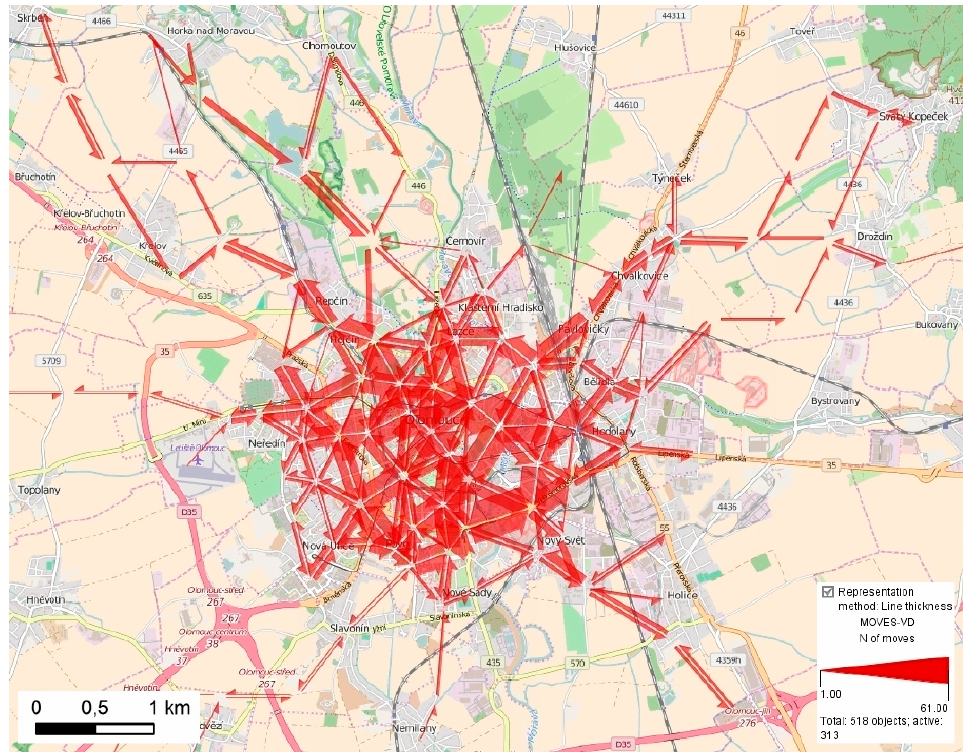
Figure 14. Dominant directions of movement in Olomouc according to public transport.